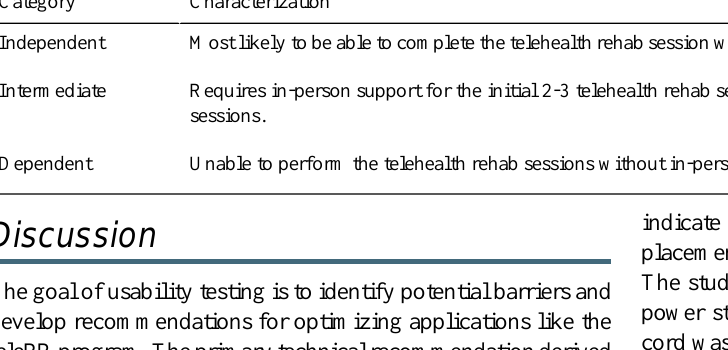
Table 3. Telehealth-delivered pulmonary rehabilitation (telePR) participant categorization.